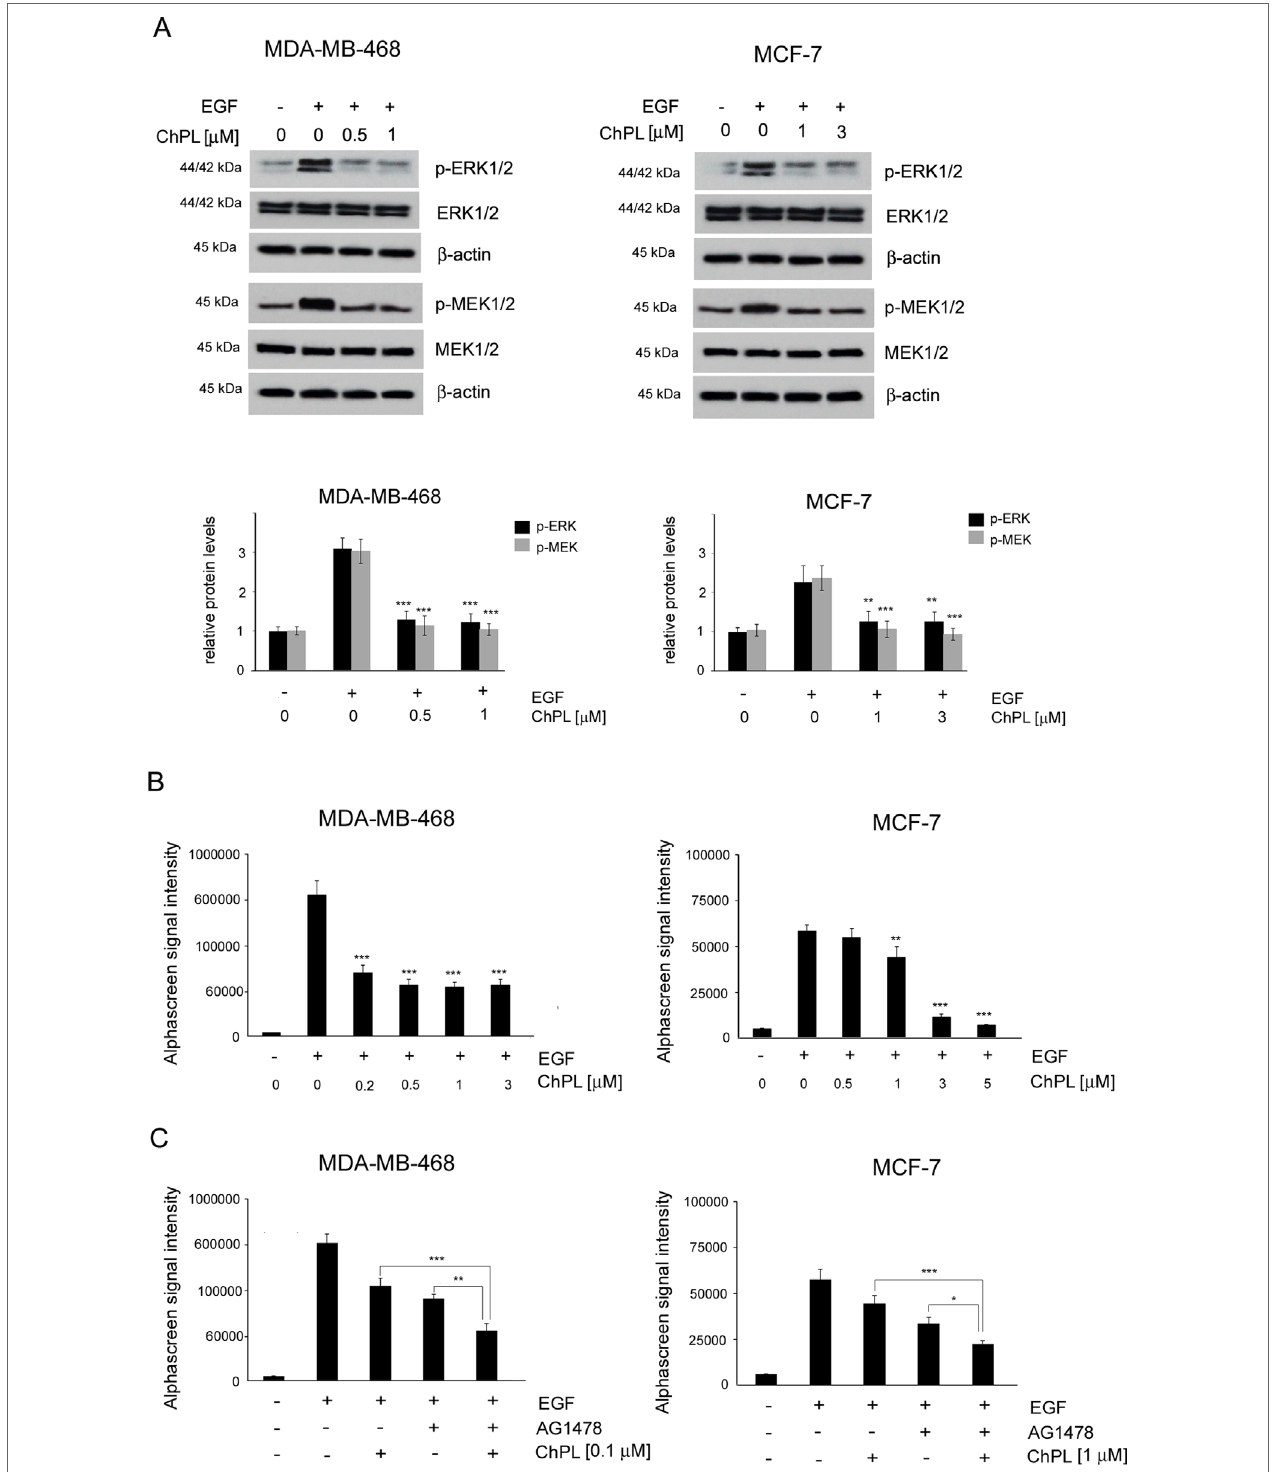
FIGURE 4 | Effects of 3-chloroplumbagin on the inhibition of MAP kinase signaling in breast cancer cells. (A) Effects of ChPL on the expression levels of proteins involved in MAP kinase signaling. Protein levels were assessed by Western blot analysis. Densitometric analysis represents protein levels normalized to total ERK1/2 and MEK1/2 levels. (B) Effects of ChPL on the levels of p-ERK 1/2 (Thr202/Tyr204) in MDA-MB-468 and MCF-7 cells. Protein levels were determined with the AlphaScreen assay. (C) Effects of ChPL and AG1478 on the levels of p-ERK 1/2 (Thr202/Tyr204) in MDA-MB-468 and MCF-7 cells. Protein levels were determined with the AlphaScreen assay. Data were analyzed by one-way ANOVA with Tukey’s post hoc tests [ p < 0.05 (*), p < 0.01 (**), p < 0.001 (***); n =